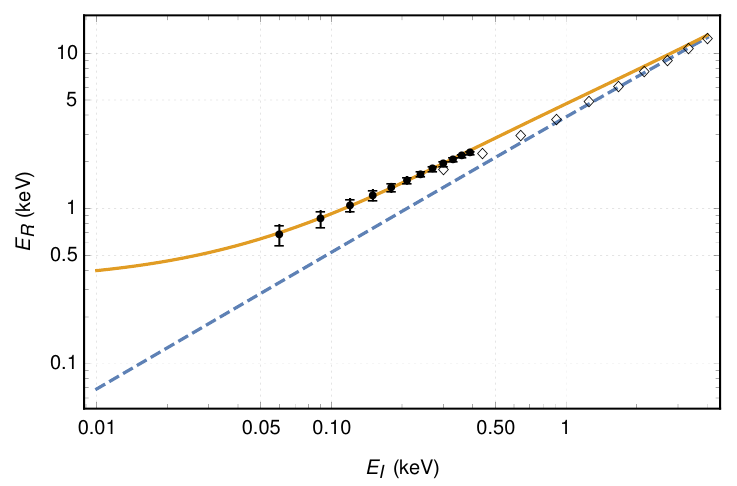
Figure 5 . Nuclear recoil quenching factors: Lindhard [34] (dashed blue line), measurements in [41] ( (cid:5) ) and in [33] ( (cid:15) ) and (cid:12)t described by eq. (B.2) (solid orange line).